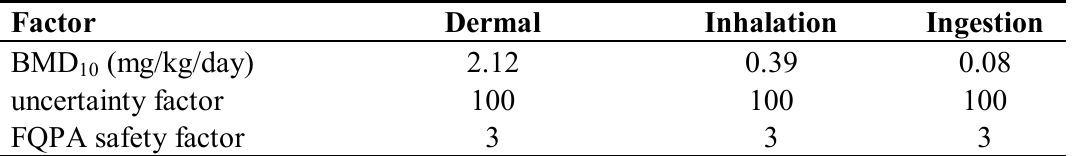
Table 5. Toxicity endpoints, uncertainty and FQPA safety factors for calculation of cumulative risk from methamidphos (index pesticide) exposure a